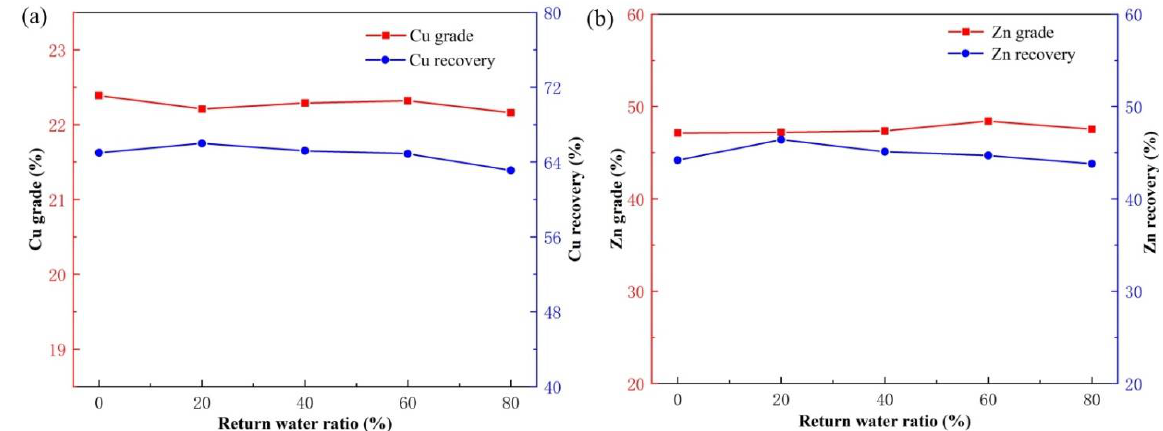
Figure 18. Effect of return water ratio on copper flotation ( a ) and zinc flotation ( b ).